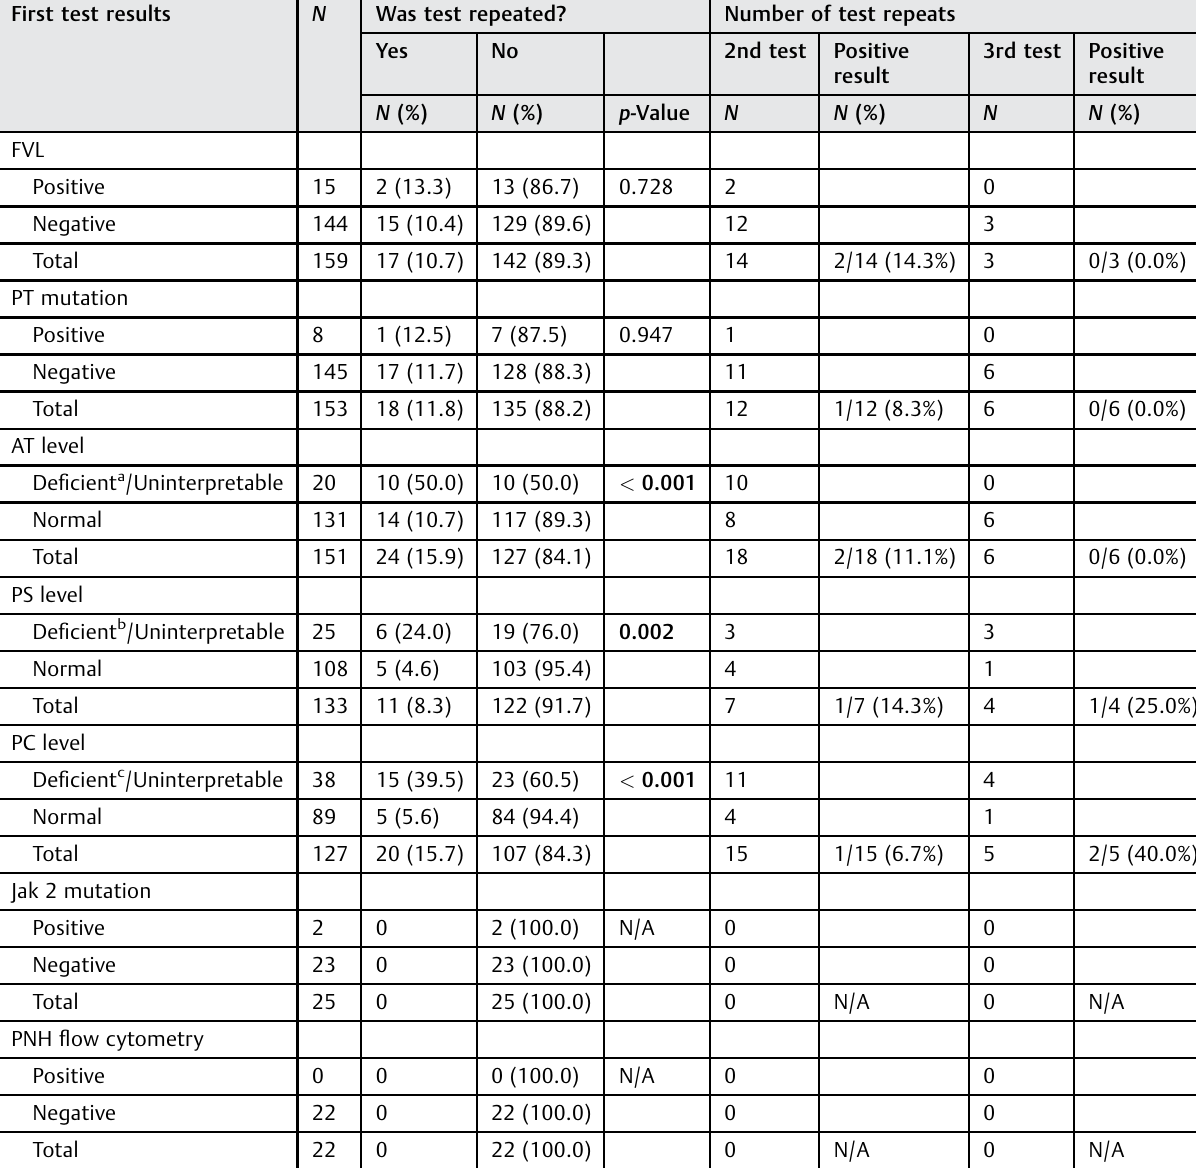
Table 4 Pattern of repeat thrombophilia testing First test